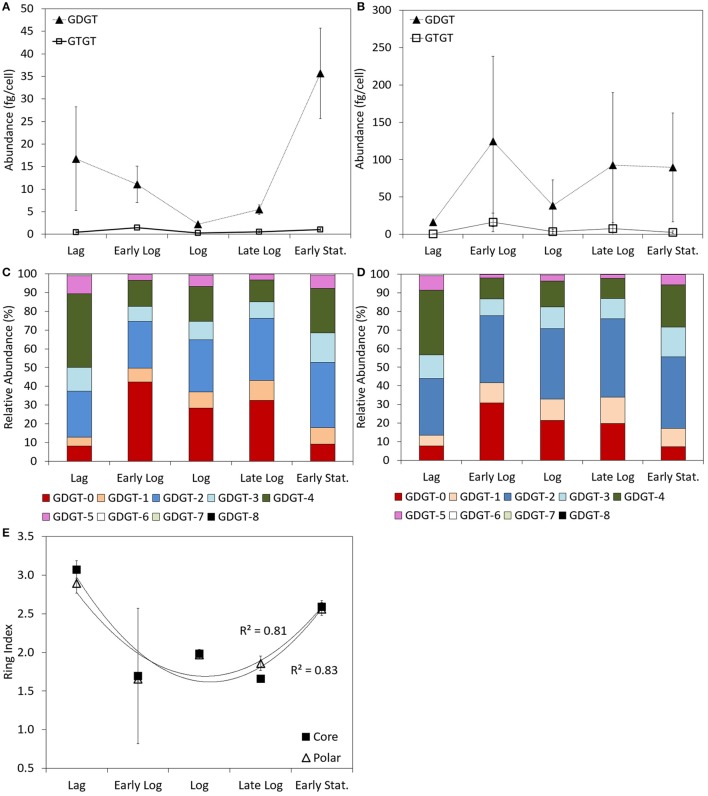
Abundance of GDGT and GTGTs per cell in the core (A) and polar (B) fractions of batch cultures of P. torridus sampled during various phases of growth. Relative abundance of individual GDGT lipids in the core (C) and polar (D) lipid fractions of cells of P. torridus harvested at different phases of growth. Calculated ring indices for cultures of P. torridus harvested at varying stages of growth (E). All cultures were grown in medium with a pH of 0.7 and were incubated at 58°C. Error bars in panels (A,B,E) represent the standard deviation of three replicate cultures.